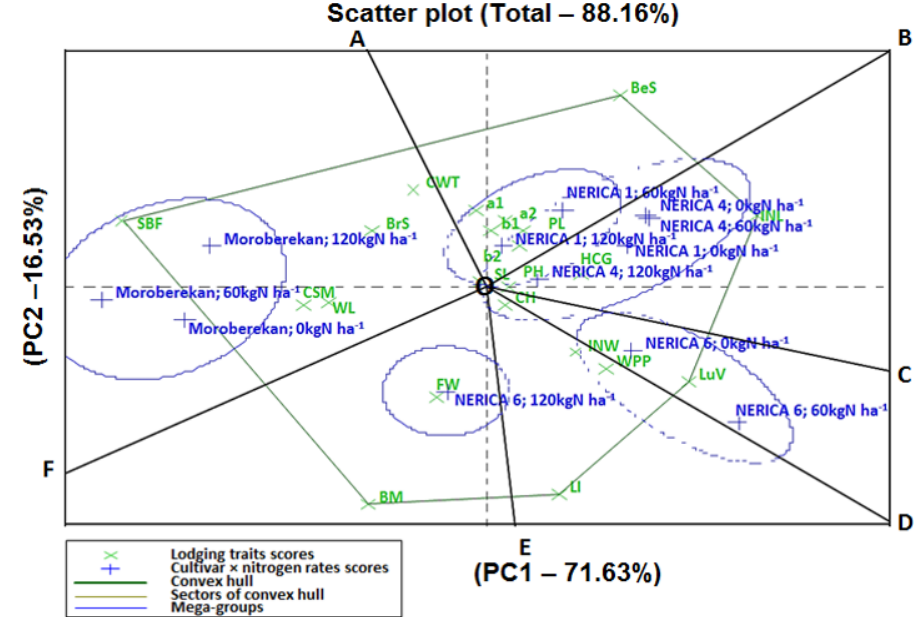
Figure 3: Principal component analysis biplot of nitrogen fertilizer rates × cultivar by traits interaction of upland rice cultivars (See Fig. 2 for the full meaning of abbreviations used in this